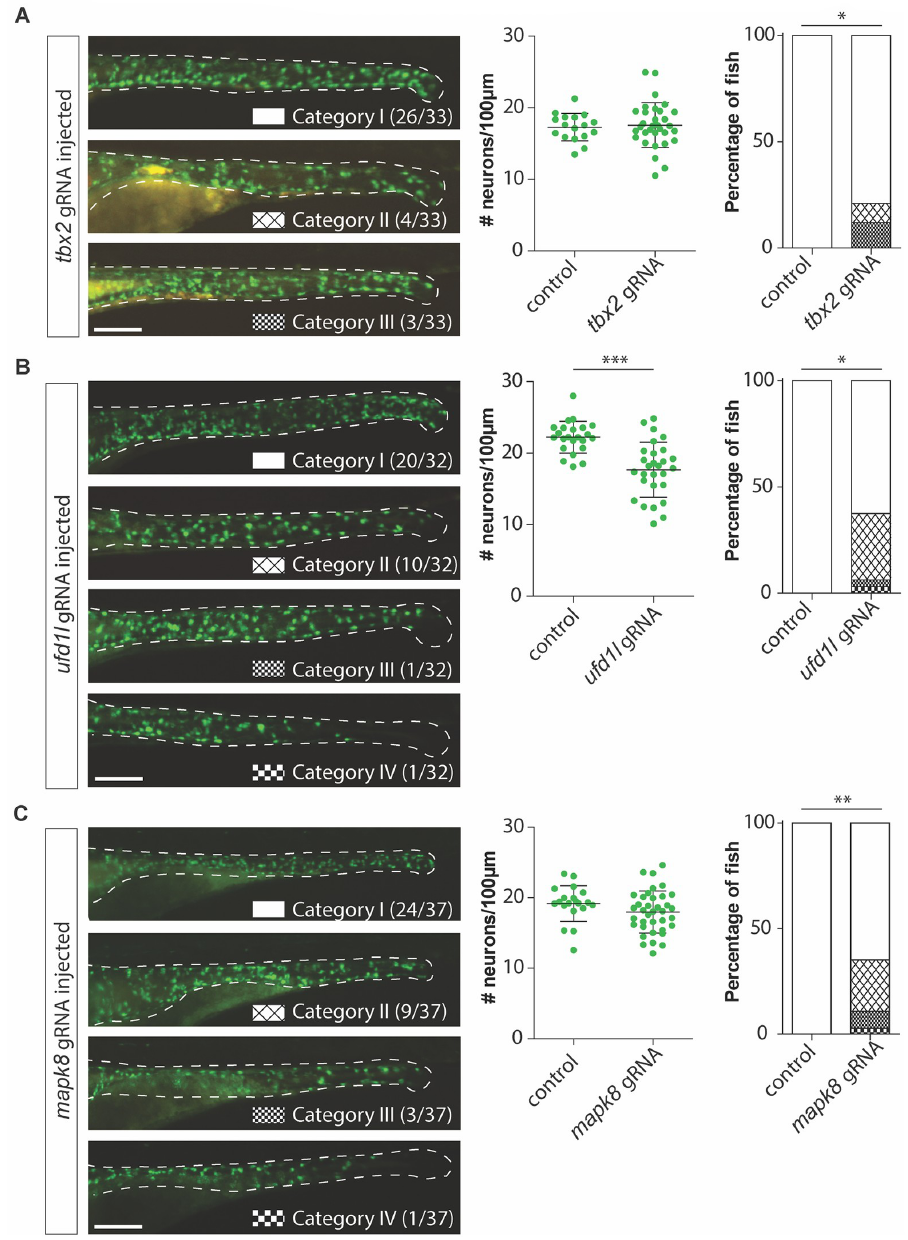
Fig 4. Validation of tbx2, ufd1l and mapk8 gene disruption shows effects on the ENS in zebrafish. (A) Figures and graphs showing that disruption of tbx2a/b in zebrafish does not result in overall significantly reduced numbers of phox2bb-GFP+ cells, however it does induce ENS phenotypes in category II and III in a significant number of zebrafish larvae. (B) Figures and graphs showing that disruption of ufd1l in zebrafish results in significantly reduced numbers of phox2bb-GFP+ cells and increase in the percentage of fish presenting with an ENS phenotype. (C) Figures and graphs showing that disruption of mapk8a/b in zebrafish does not result in overall significantly reduced numbers of phox2bb-GFP+ cells, however it does induce ENS phenotypes in a significant number of zebrafish larvae. Statistical tests used: students t-test and "N-1" Chi-squared test; � p < 0.05 �� p < 0.01 ��� p < 0.001; Exact p-values and statistics can be found in S11